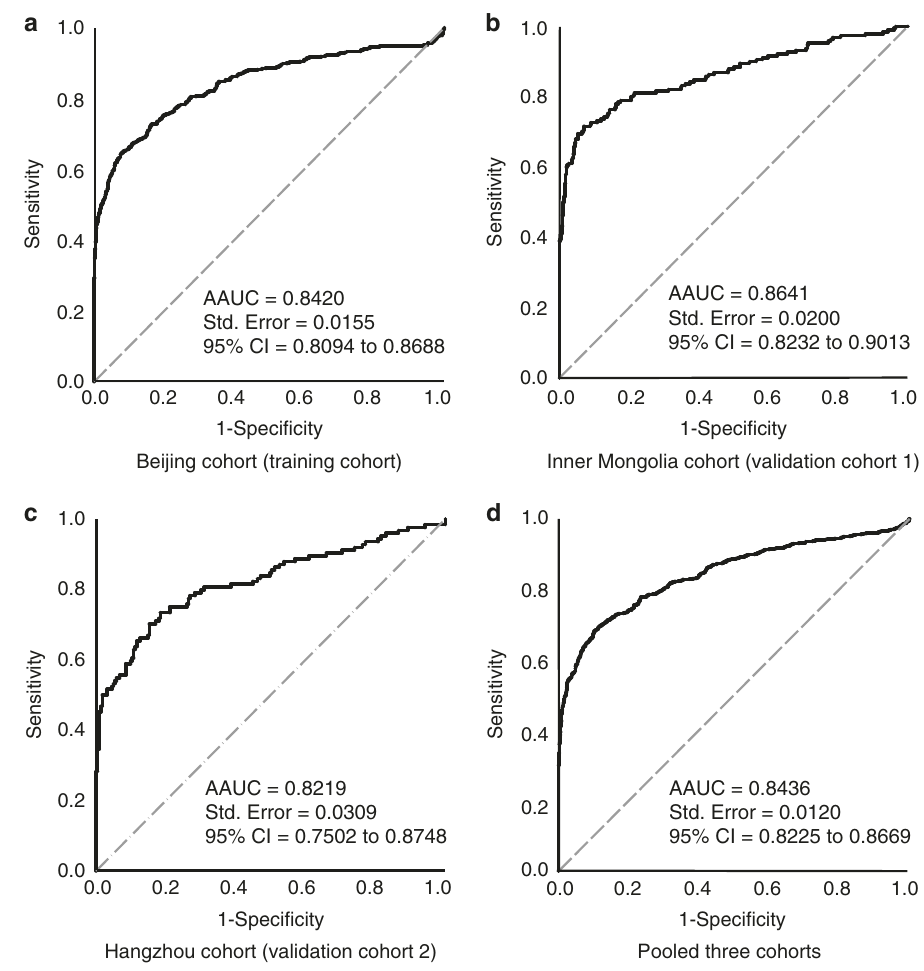
Fig. 3 AROC curves of sSR-A for RA diagnosis. Covariate-adjusted receiver operating characteristic curve (AROC) analysis was performed to evaluate the performance of sSR-A in diagnosis of RA, with age and gender as the confounders. The area under the age-adjusted and gender-adjusted ROC curve (AAUC) was 0.8420 (95% CI extending from 0.8094 to 0.8688) in Beijing cohort a , 0.8641 (95% CI extending from 0.8232 to 0.9013) in Inner Mongolia cohort b , 0.8219 (95% CI extending from 0.7502 to 0.8748) in Hangzhou cohort c , and 0.8436 (95% CI extending from 0.8225 to 0.8669) in the Pooled three cohorts d . AROC: covariate-adjusted receiver operating characteristic curve; AAUC: area under the covariate-adjusted ROC curve; CI: con fi dence interval (covariate-adjusted ROC curve